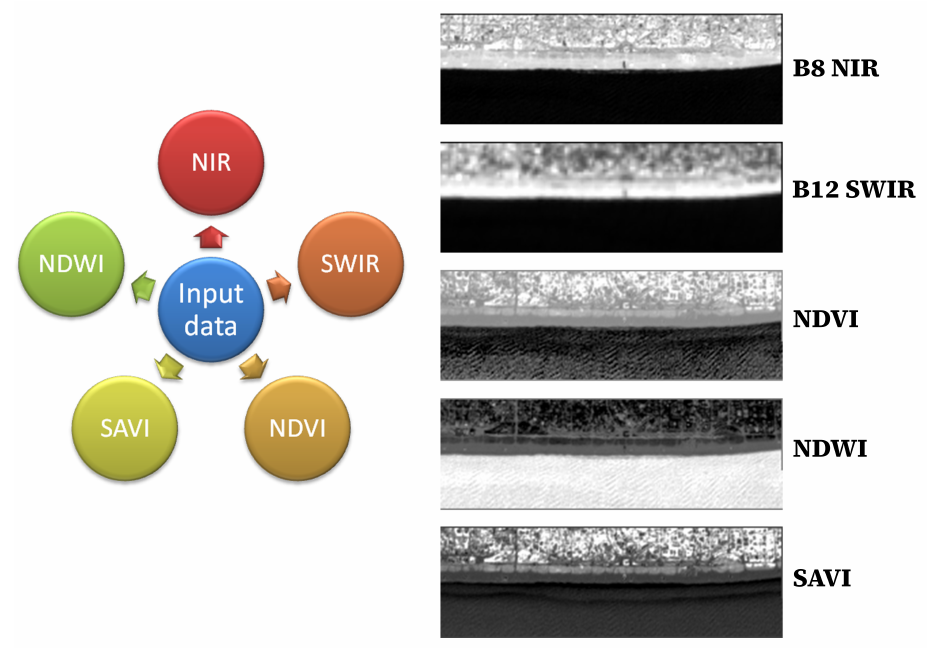
Figure 3. Sentinel-2 tested bands and indices for shoreline